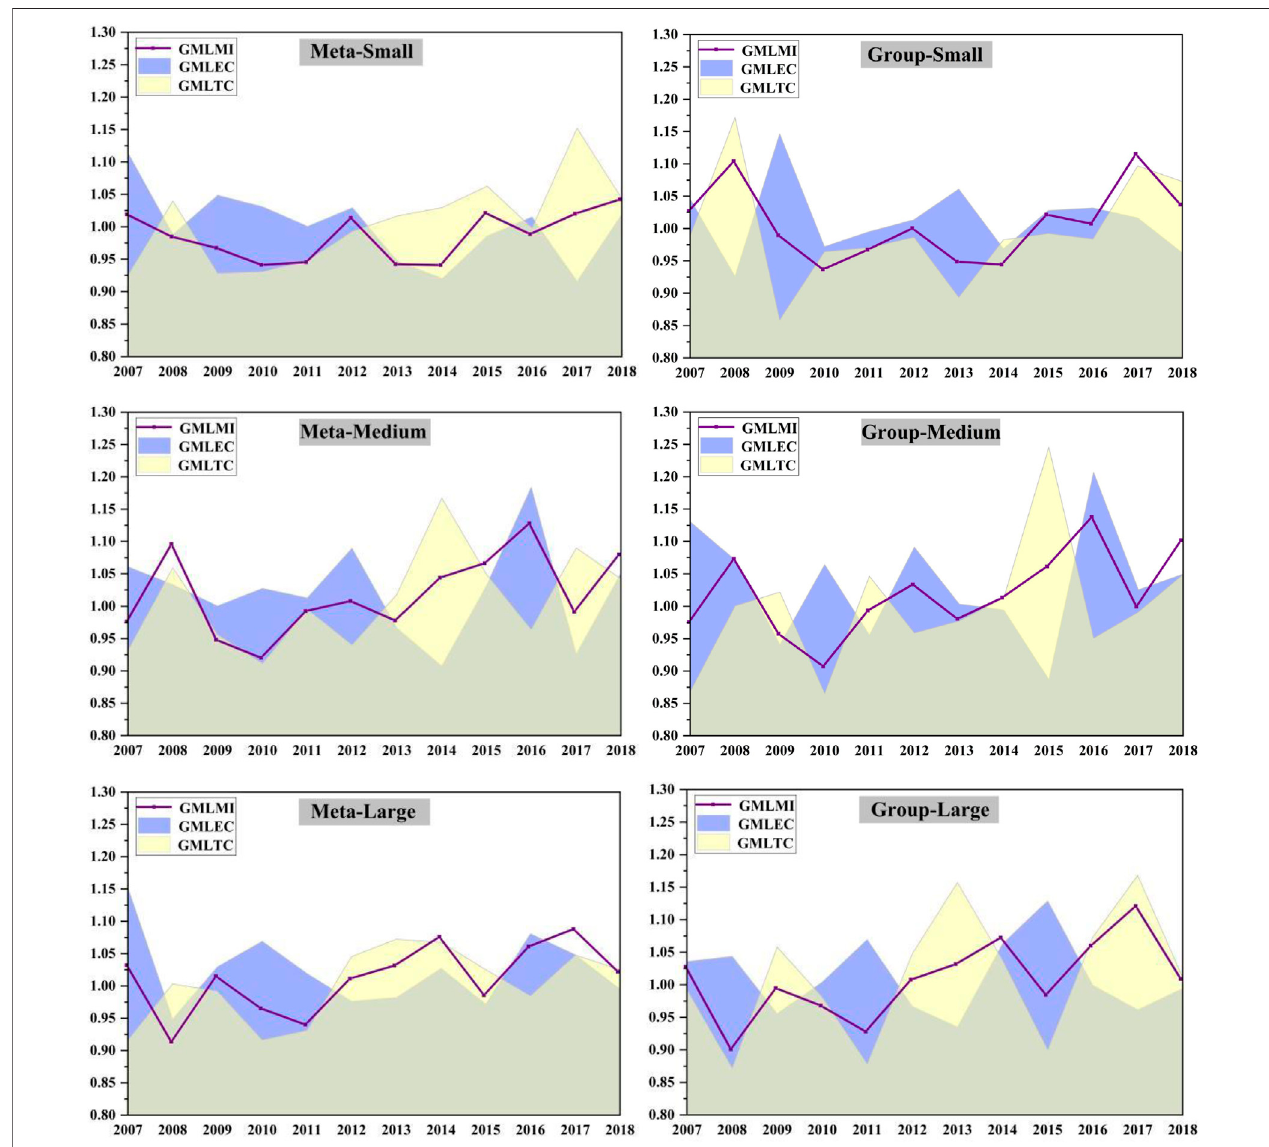
FIGURE 6 | Three-sized GMLMI and its decomposition index from 2007 to